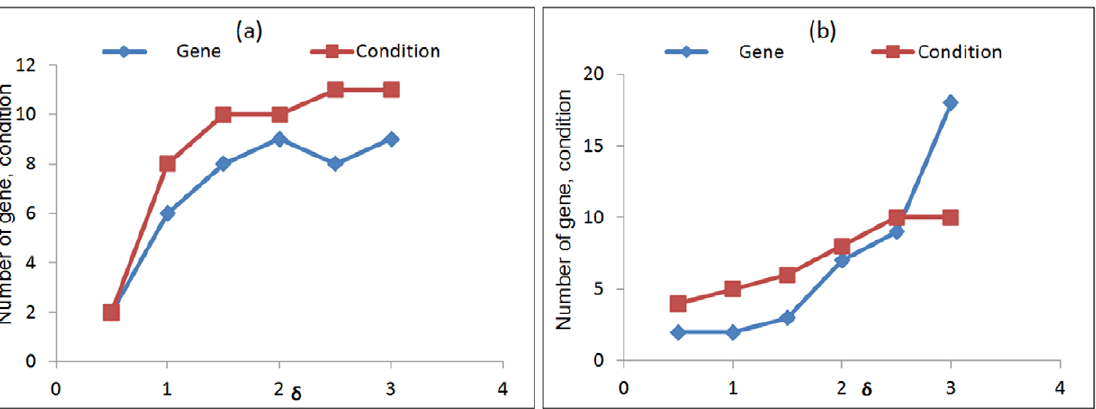
Figure 3. The effect of residue threshold, d , on the number of genes and conditions in the optimal bi-cluster. The volume of the bi- cluster is highly sensitive to the prescribed residue on threshold. Increasing the threshold was found to increase the bi-cluster volume for both 2- dimensional (2-D) culture (a) and 3-dimensional (3-D) culture (b).